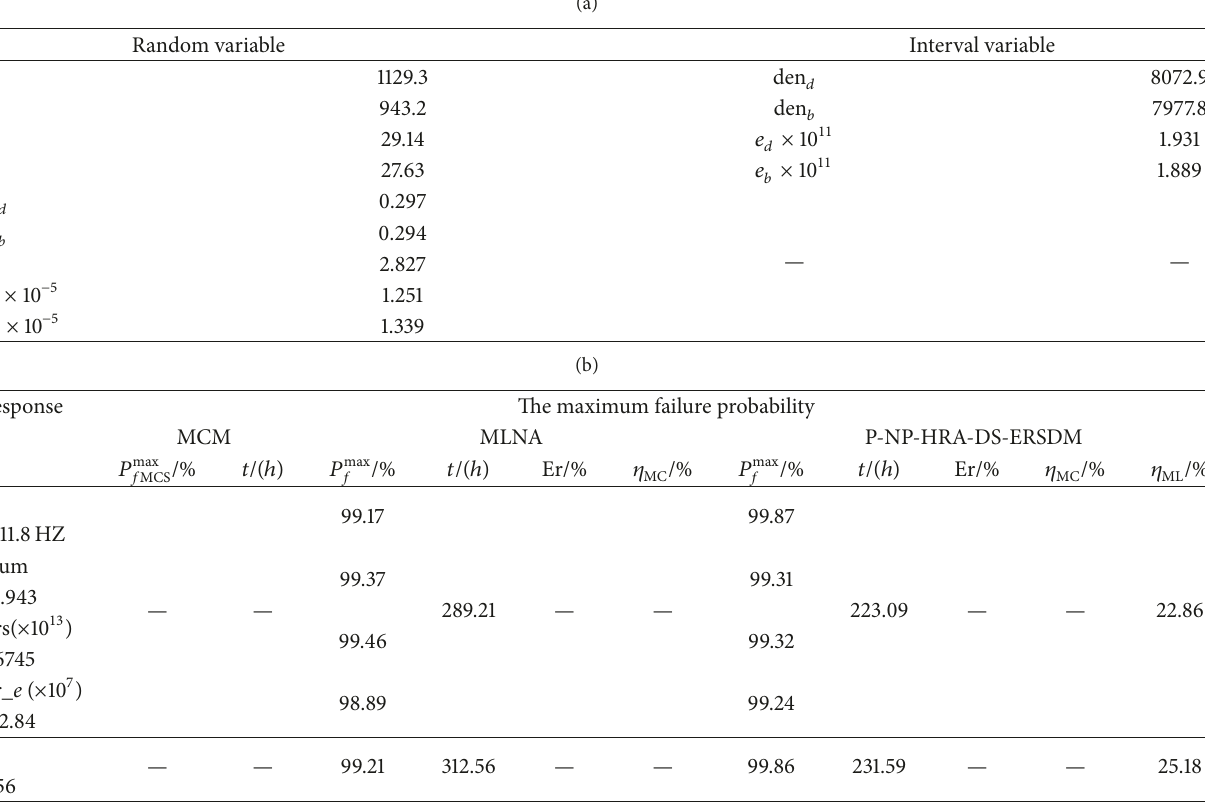
Table 4: Analysis results of modal and vibration response of P-NP-HRA-DS-ERSDM for the mistuned